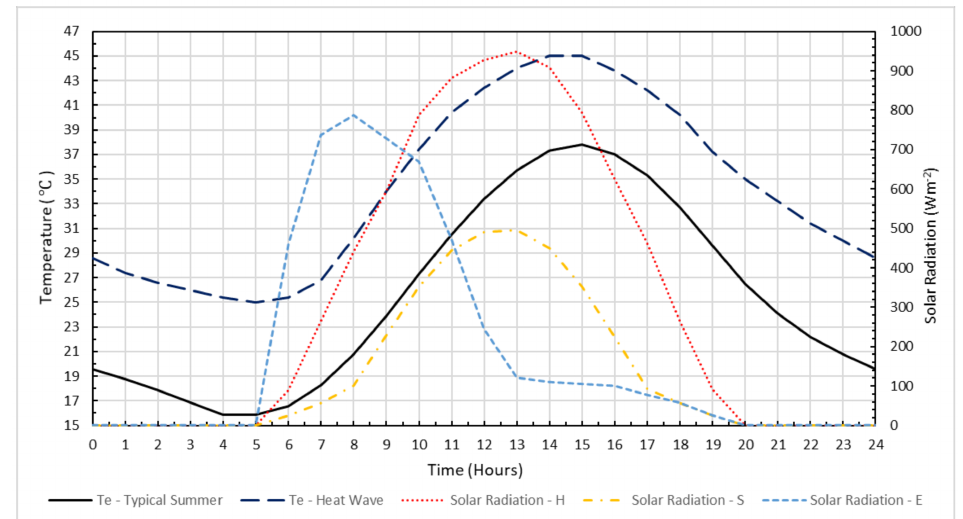
Figure 6. Temperature and solar radiation (Horizontal, South, and East) hourly profiles considered in the typical summer and in the heat wave conditions / scenarios.